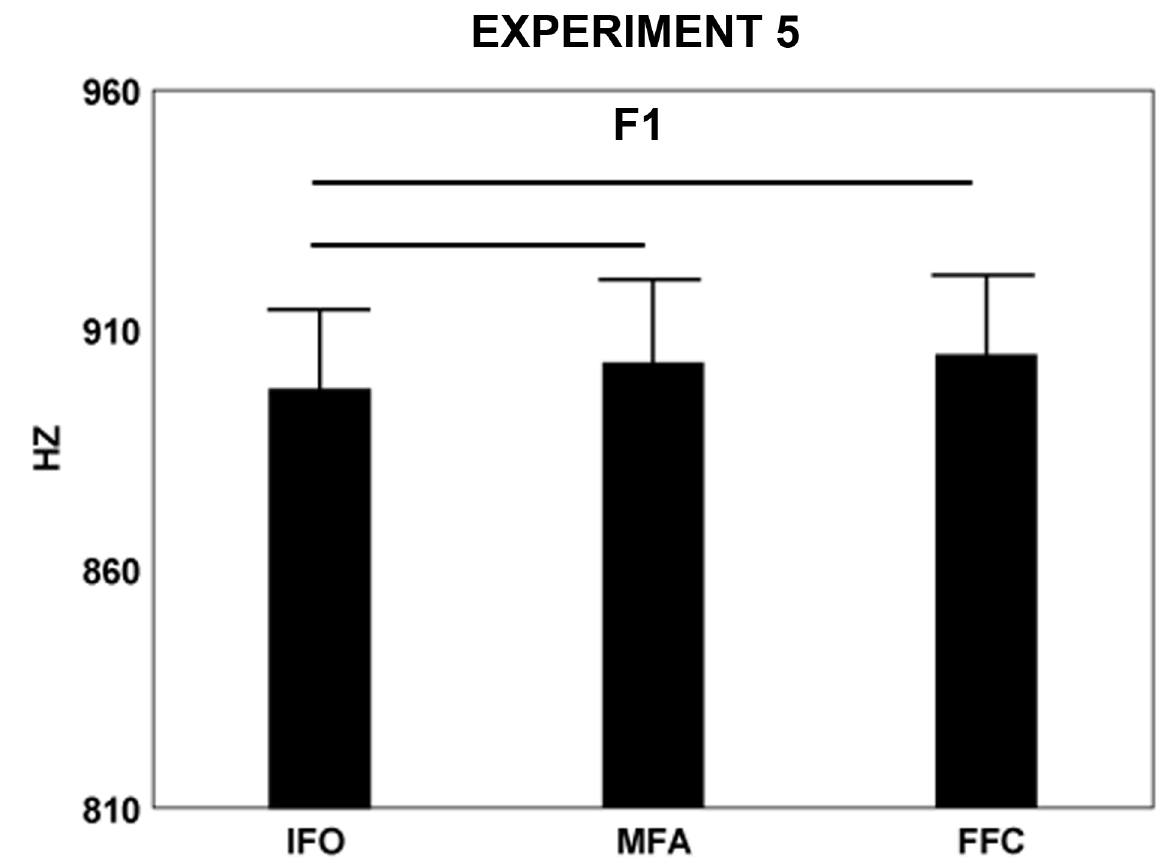
Figure 3. Mean RT and voice spectra parameter (F1) of the syllable /ba/ and /da/ after presentation of three phases of grasp (IFO, initial finger opening, MFA, maximal finger aperture, FFC, final finger closing, experiment 5). Other conventions as in Figure